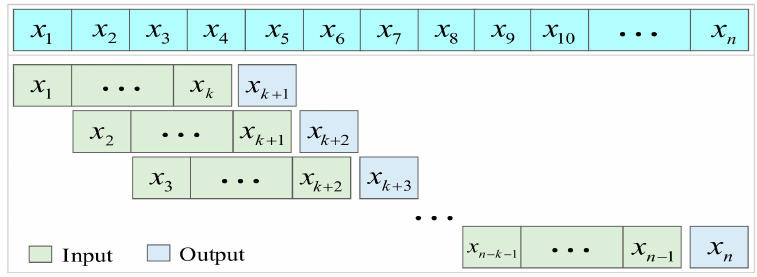
Figure 3. Sequence processing of tra ffi c